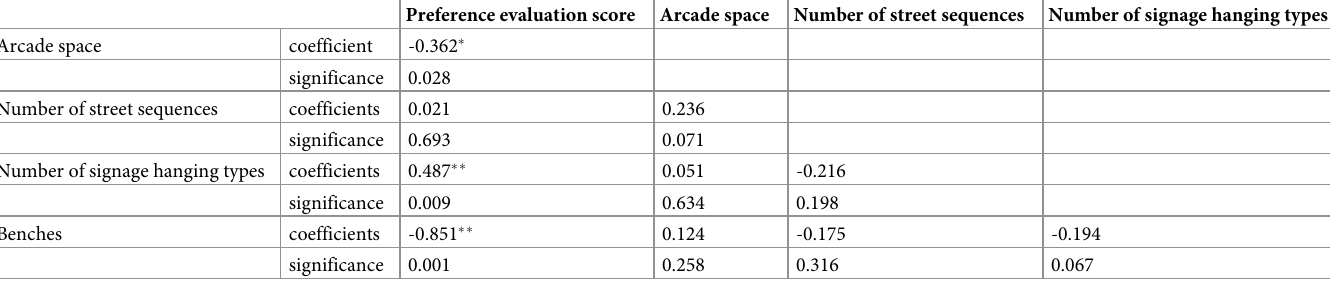
Table 3. Correlations between landscape preferences and pedestrian street